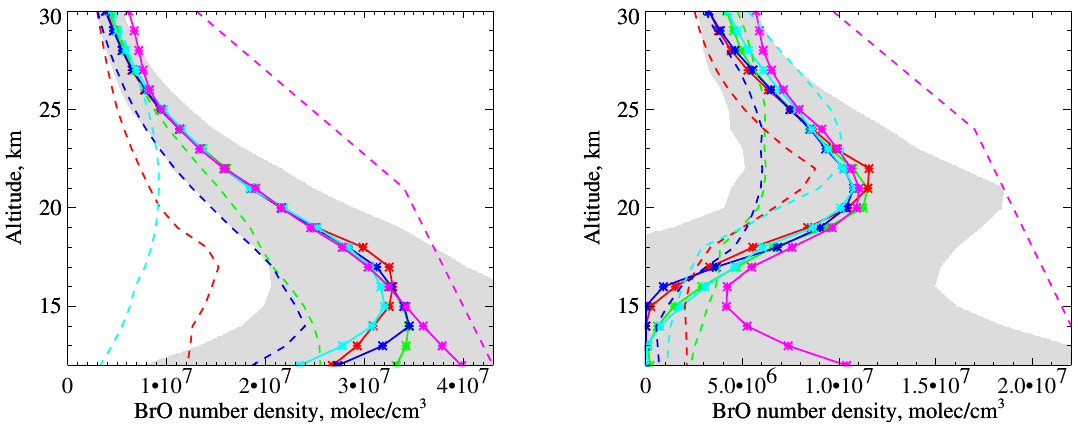
Fig. 7. Dependence on a priori information for typical retrievals at high latitudes (left panel) and in the tropics (right panel). Dashed lines of different colors depict a priori profiles used for the retrieval (see text for details). For each a priori the corresponding retrieved profile is shown in the same color by a solid line with asterisks. Grey areas show the uncertainty regions of the retrieved profiles. The results are obtained using the IUP Bremen